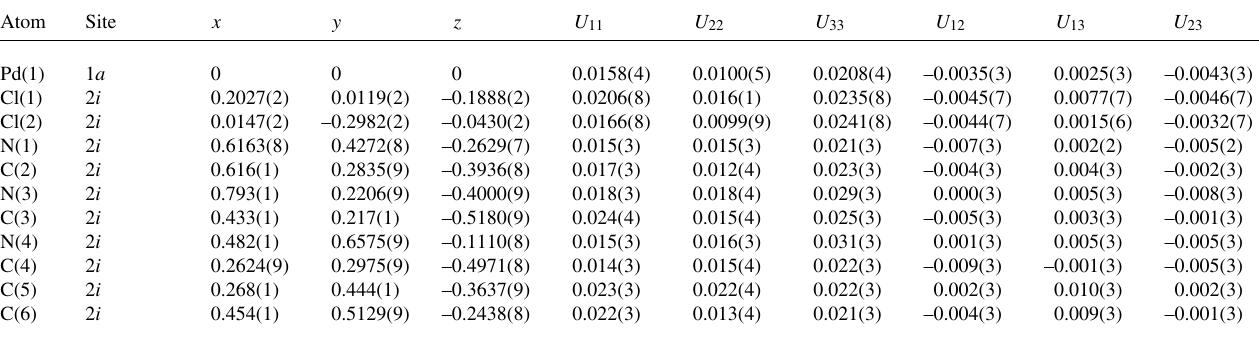
Table 3. Atomic coordinates and displacement parameters (in Å 2 ) .